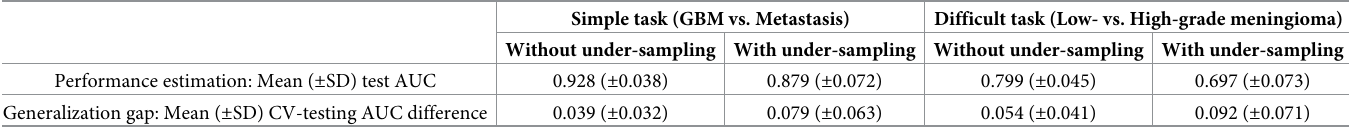
Table 1. Model performance estimate and generalization gap according to the sample size and the level of task difficulty. Simple task (GBM vs. Metastasis) Difficult task (Low- vs. High-grade meningioma) Without under-sampling With under-sampling Without under-sampling With under-sampling